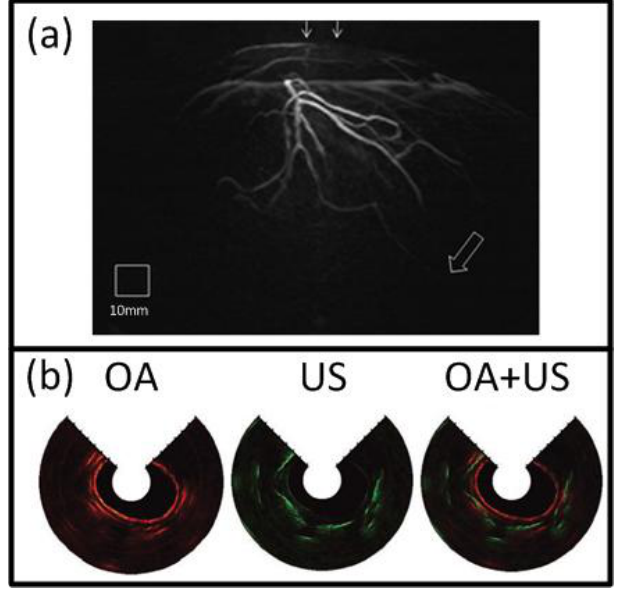
Figure 14. ( a ) OA angiography of the breast by Kruger et al. without contrast enhancement [49]. Maximum intensity projection of a 57 year old volunteer’s breast showing the vasculature from superficial areas (solid arrows) up to considerable depth (hollow arrow). Reprinted with permission from American Association of Physicists in Medicine ; ( b ) Simultaneous, dual-wavelength OA and US endoscopy by Yang et al. [47]. Ultrasonic, optoacoustic and combined cross-sectional in vivo images of a rabbit esophagus near the lungs taken at 584 nm. Reprinted with permission from Nature Publishing